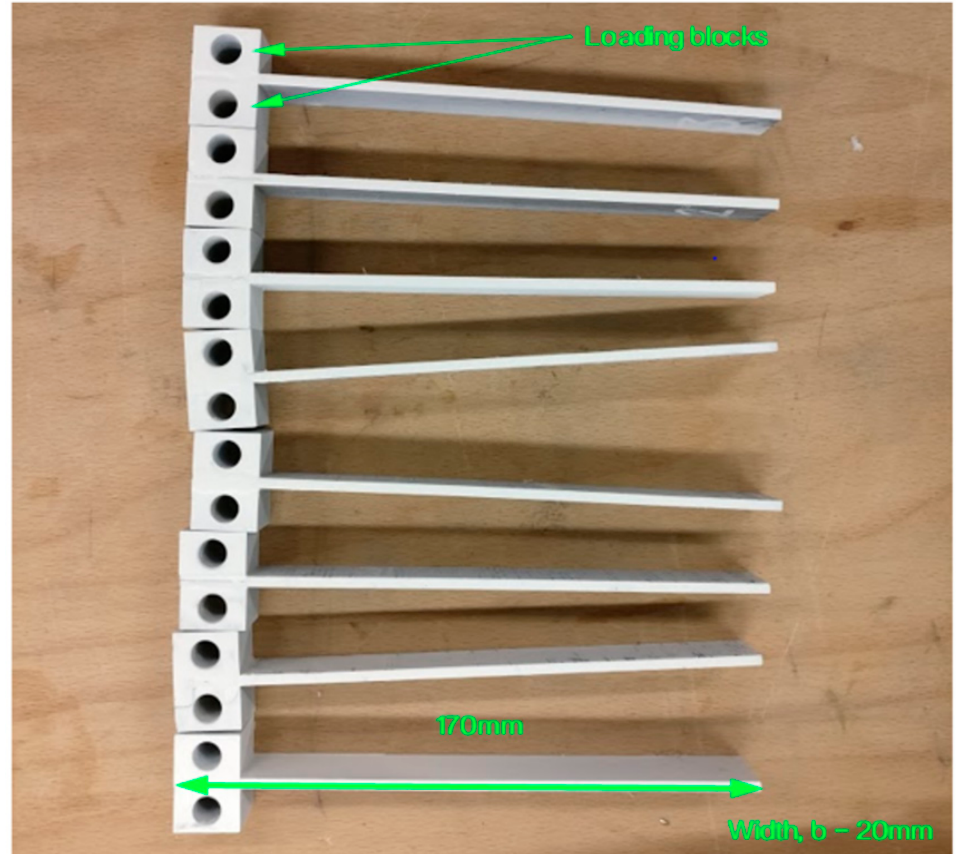
Figure 3. The DCB specimens that have been painted white prior to being marked to enhance visibility.